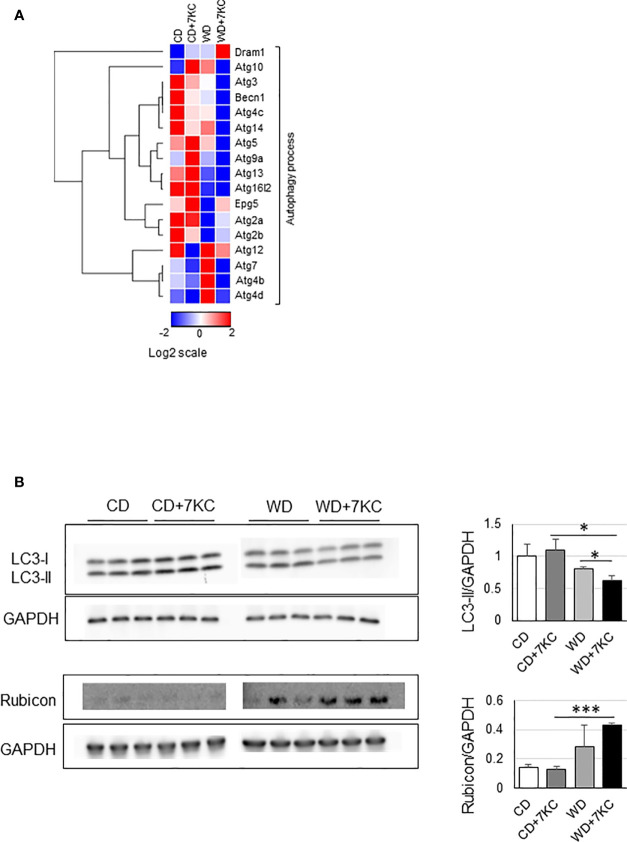
Effect of 7KC on autophagy in liver of ob/ob mice fed CD or WD for 4 weeks. (A) Heatmap of autophagy process-related genes, (B) Western bot for LC3-II and Rubicon. All values are presented as the means ± SD. ANOVA with Tukey test, n = 3 in B; *p < 0.05, ***p < 0.001.